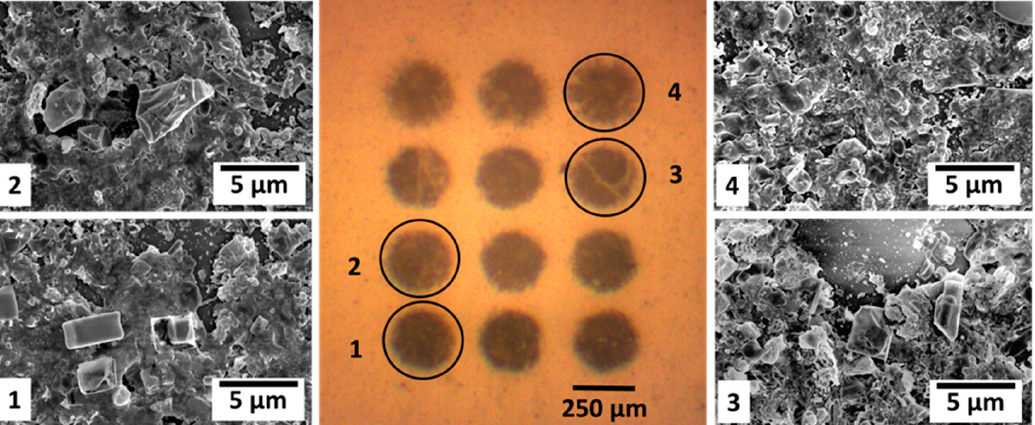
Figure 3. (Center image) Optical microscopy image of a Pd-SnO 2 pixel array obtained by varying the laser fluence between 100 mJ/cm 2 (lowest row) and 250 mJ/cm 2 (top row). Images 1–4 represent the scanning electron microscopy images taken in the middle of the Pd-SnO 2 pixel transferred at: image 1—100 mJ/cm 2 ; image 2—150 mJ/cm 2 ; image 3—200 mJ/cm 2 ; and image 4—250 mJ/cm 2 .